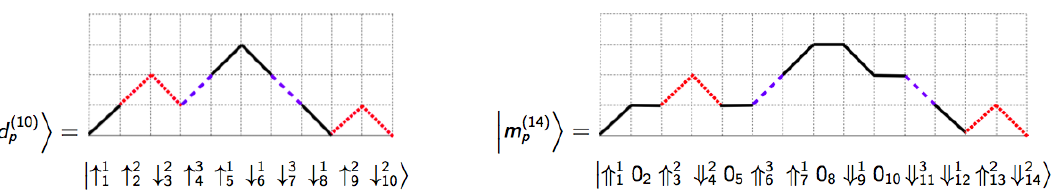
Figure 1: An example of Dyck path (left panel) and of a Motzkin path (right panel) with q = 3 colors, which contribute to the ground states for the 3-color spin models, respectively, the spin- 5 Fredkin model and the spin-3 Motzkin 2